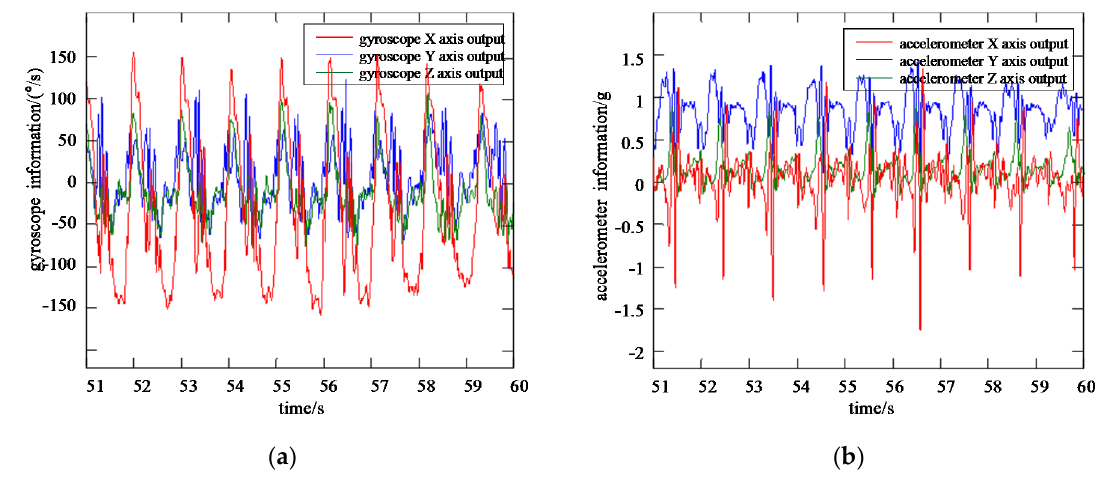
Figure 6. Gyroscope and accelerometer information from pedestrian thigh ( a ) Gyroscope information from pedestrian thigh; ( b ) Accelerometer information from pedestrian thigh